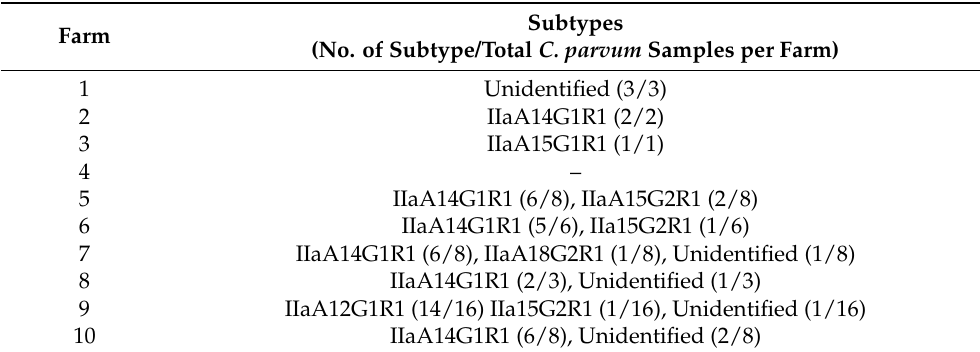
Table 2. Number of Cryptosporidium parvum gp60 subtypes identified out of total C. parvum -positive samples per